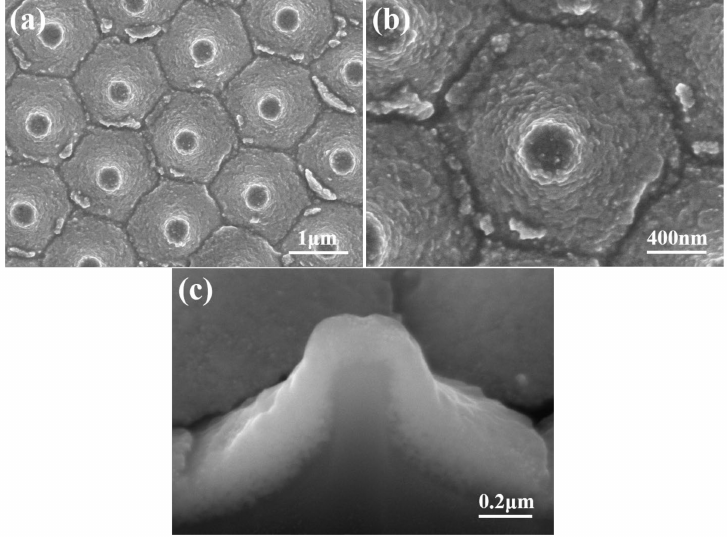
Figure 3. SEM images of an investigated template with ( a ) a low magnification and ( b ) a high magnification; and ( c ) the FIB cross-sectional view of the